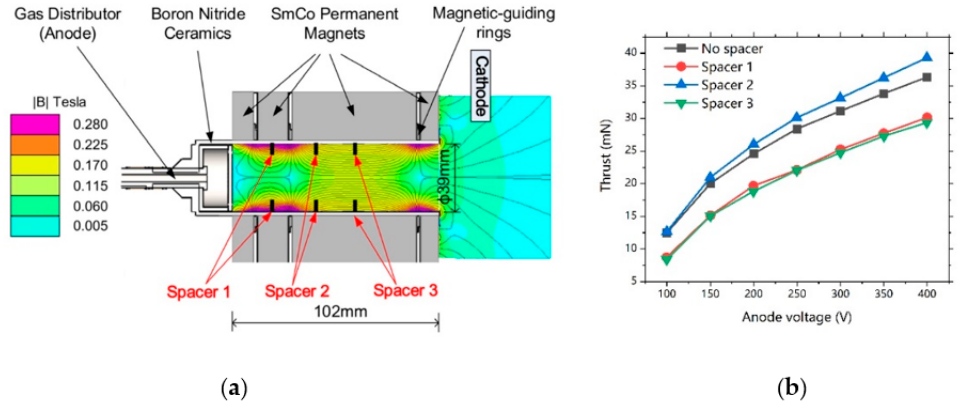
Figure 11. Variable cross-section effects of the cusped field thruster. ( a ) Spacer configuration and ( b ) thrust difference with different spacer locations.